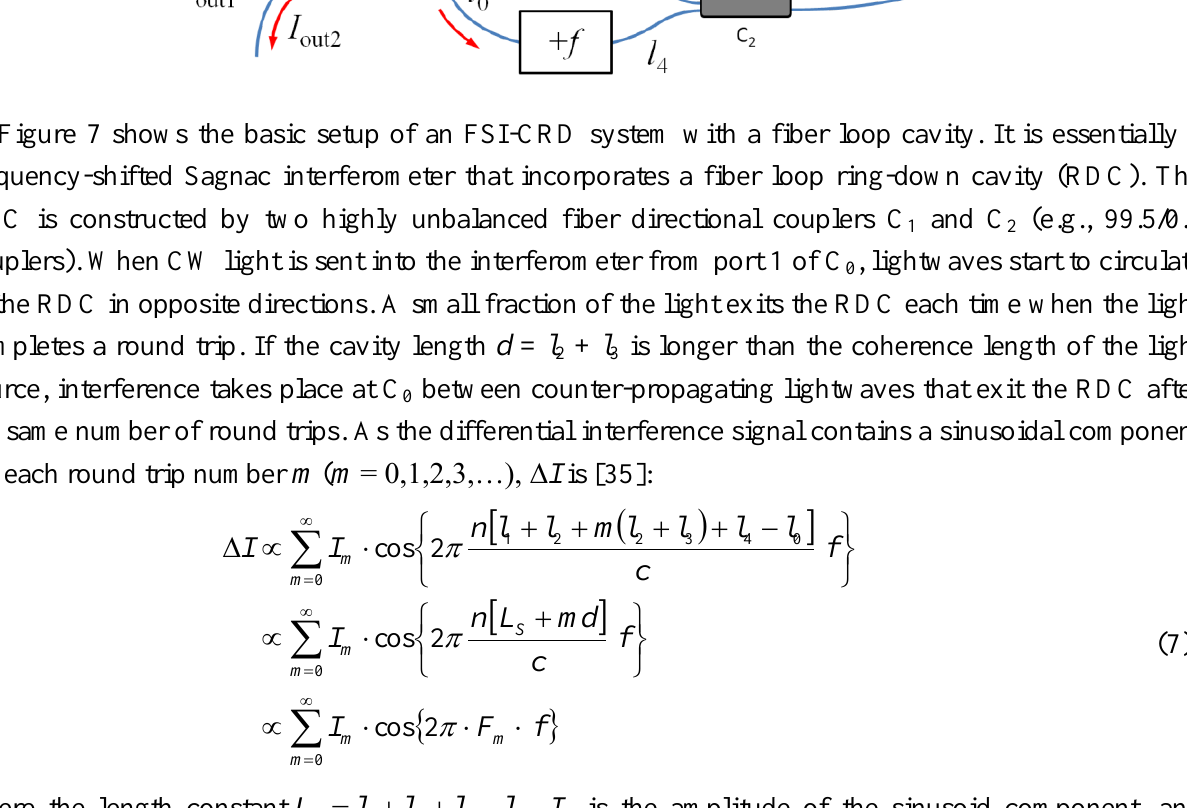
: 50/50 fiber directional coupler; 0